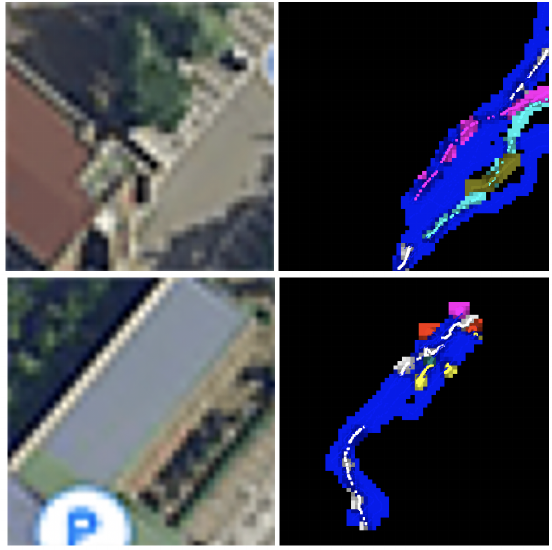
Figure 10. Wrong classification